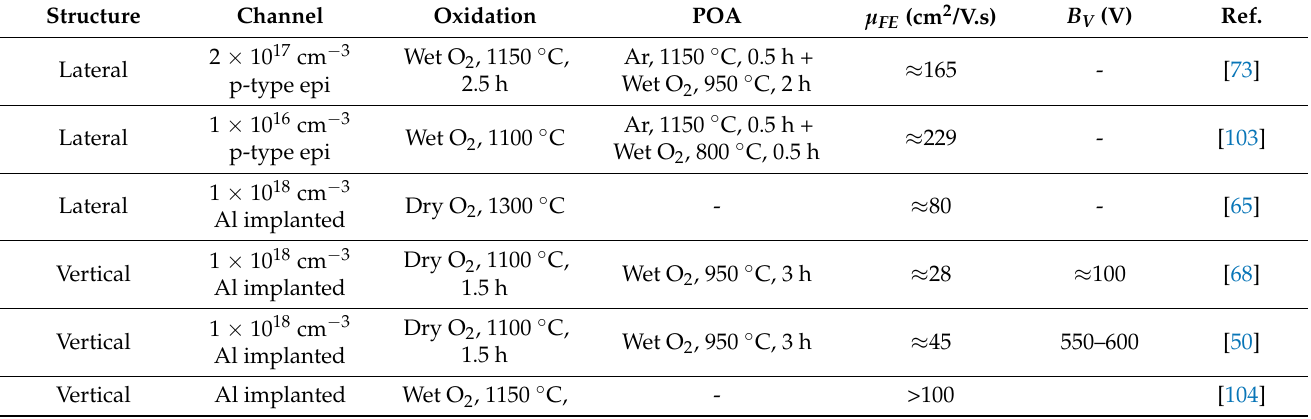
Table 6. A summary of literature data on the forward and reverse performance of 3C-SiC